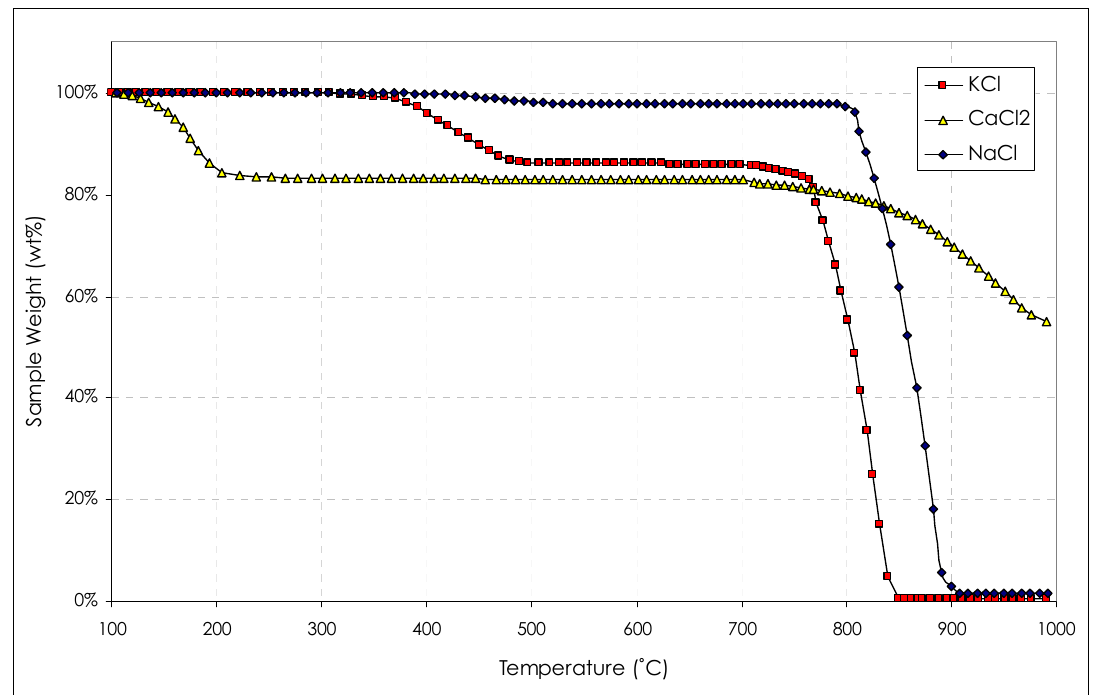
Figure 10. Mass loss profiles of alkali-chlorine